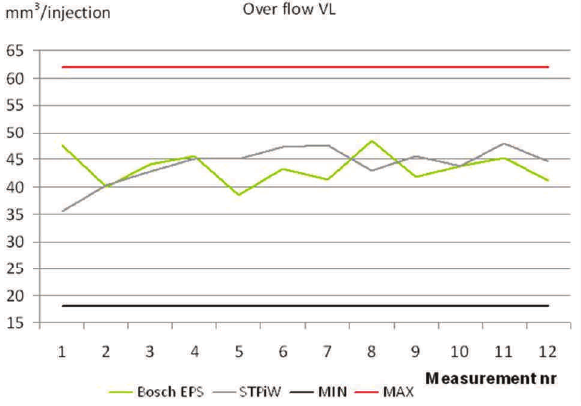
Fig. 10. Return quantity in VL test (actuation time 1300 µs, pressure 130